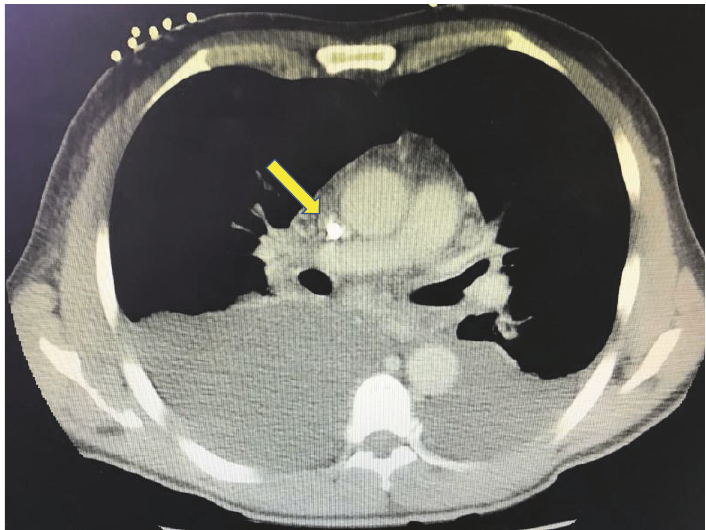
Figure 3: Demonstrates the stenotic area in the SVC around the